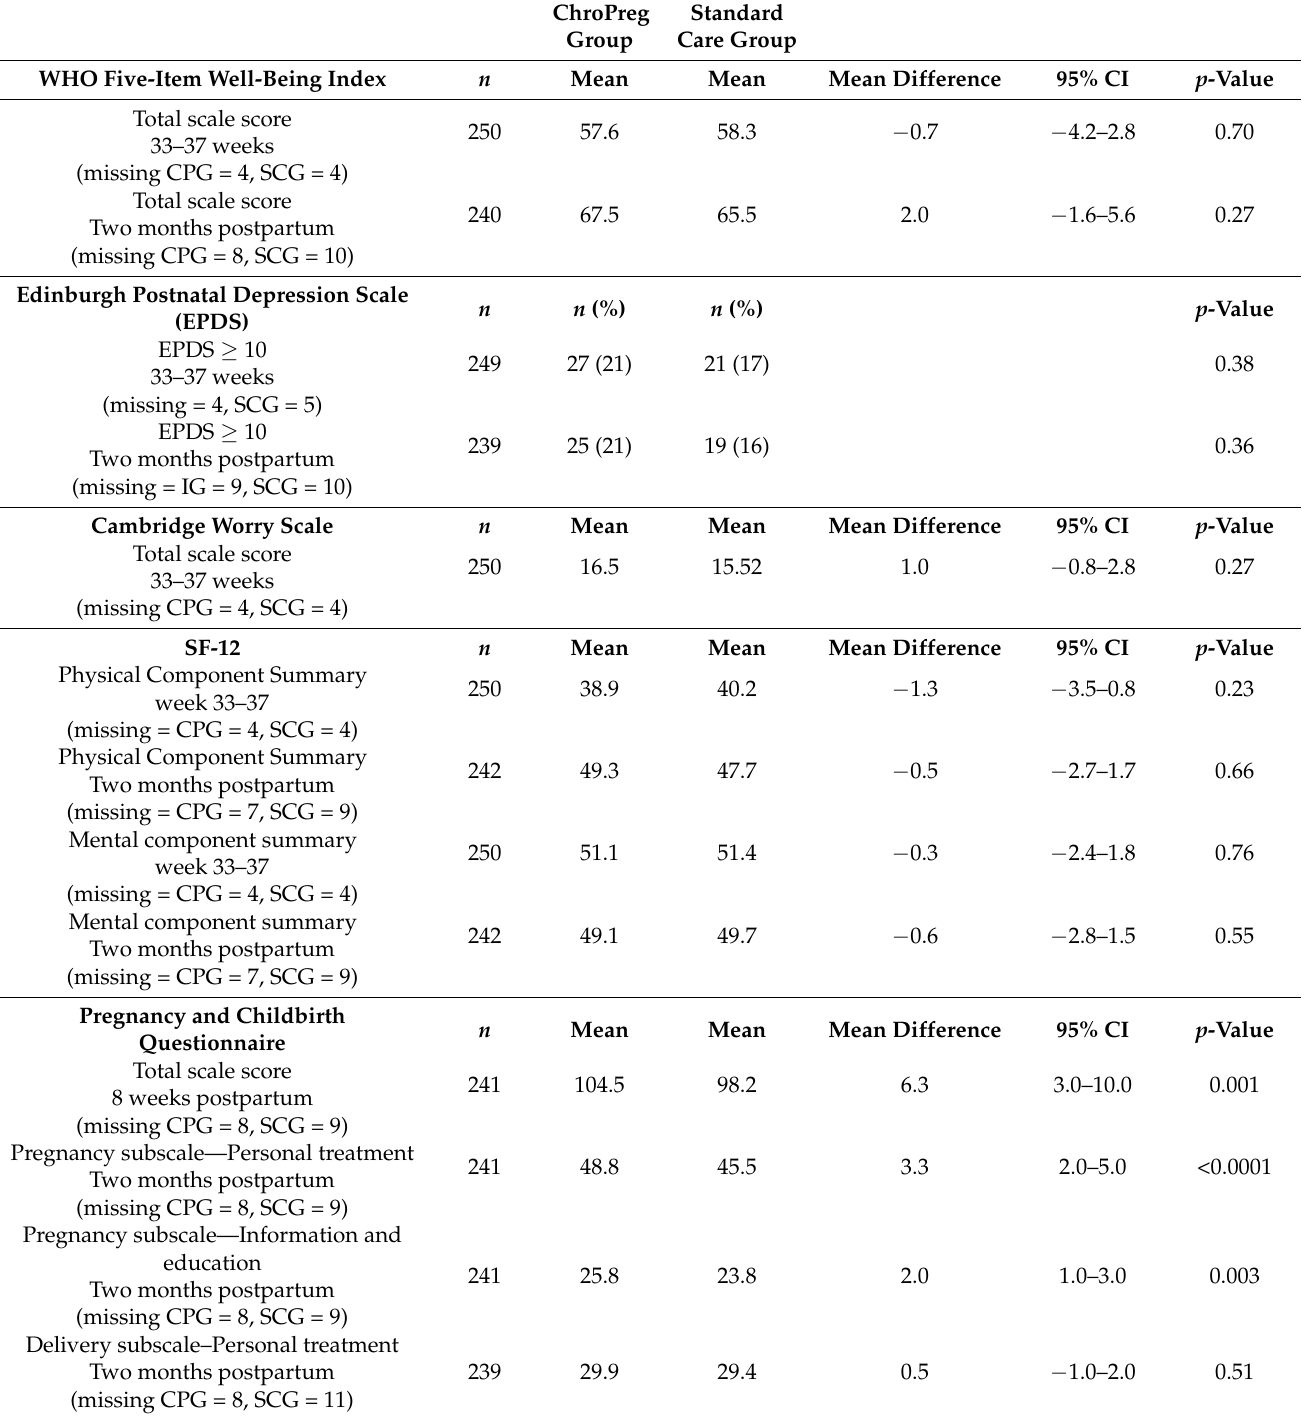
Table 4. Patient-reported outcomes for the intention-to-treat population according to group allocation. All analyses are based on the constrained covariance pattern model.